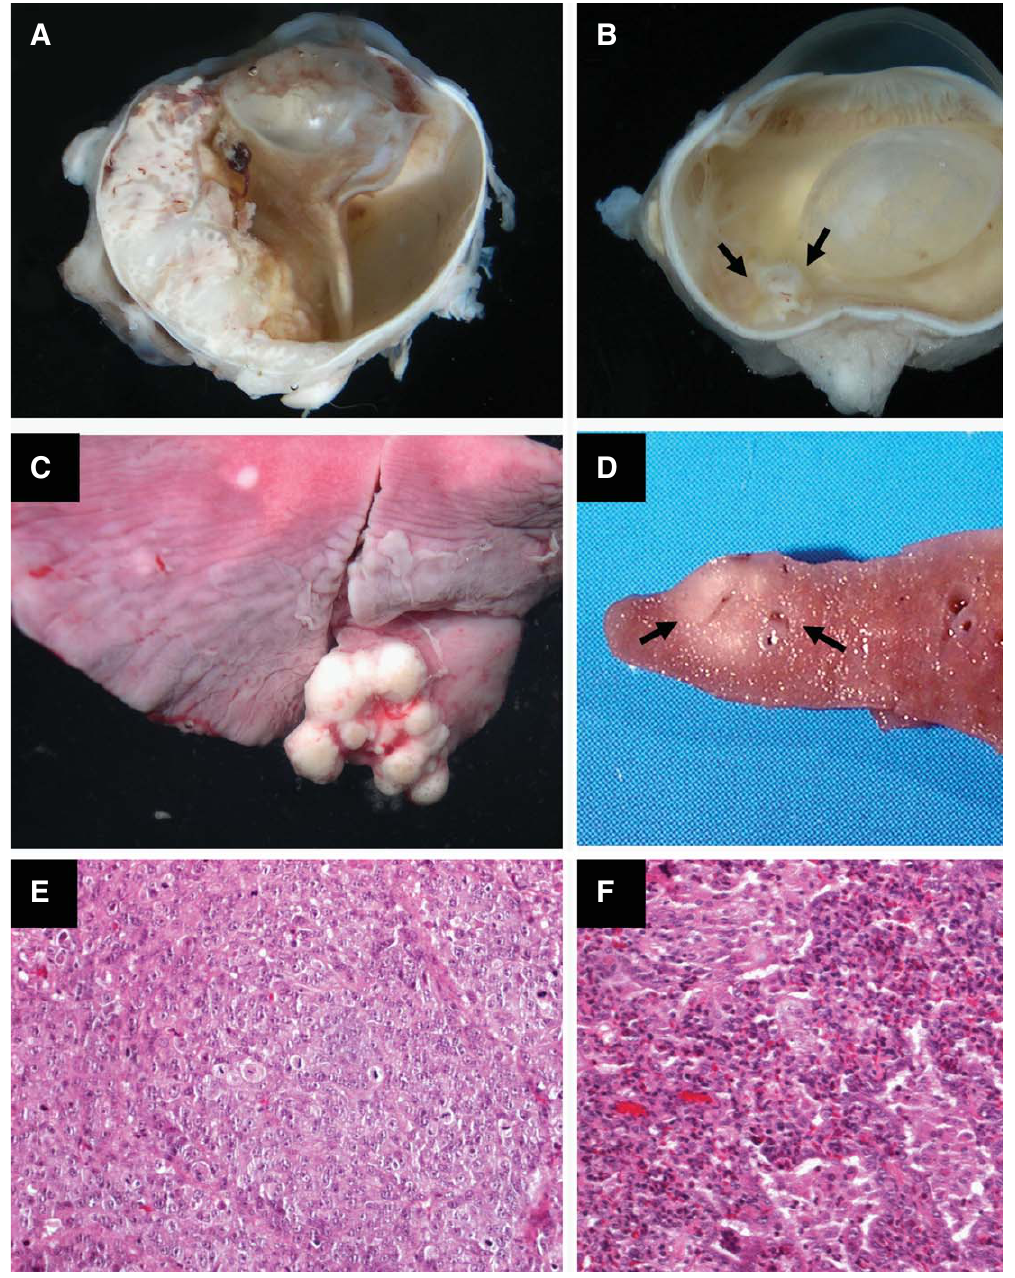
Fig.1. Grossexaminationofpost-mortemspecimens:A)Enucleatedeyefromananimalofthecontrolgroupharboringalargewhitishintraocular tumor occupying almost half of the vitreal cavity. B) An eye from the group treated with Imatinib mesylate showing a much smaller tumor (arrows). C) White nodules representing metastatic dissemination to the lung. D) A cross-section of the lung showing a metastatic nodule (arrows). Microscopic images: E) Intraocular tumor, epithelioid cell-type with several mitotic figures (H&E, × 200). F) Metastatic nodule revealing the malignant cells interspersed with an inflammatory infiltrate (H&E, ×